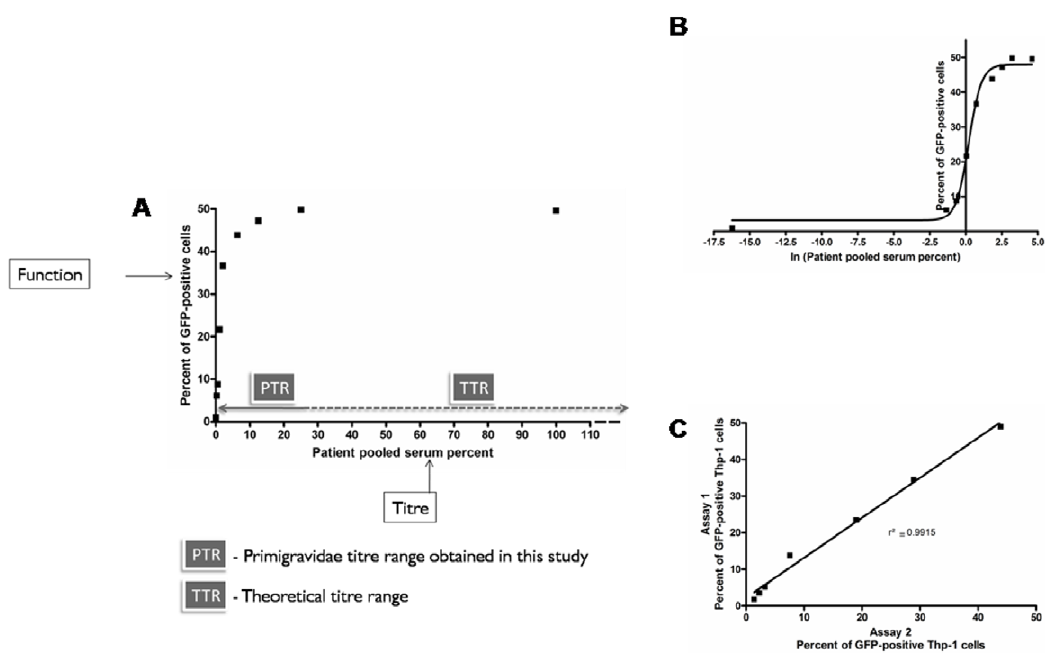
Figure 1. Phagocytosis profile of a typical uThp-1 phagocytosis assay standard curve and inter-assay reproducibility. A) Typical standard curve plot of percentage of patient pooled serum against percent of GFP-positive uThp-1 cells with indications of absolute phagocytosis values used for phagocytic antibodies’ function, titre and both the titre range obtained in this study (PTR) and a theoretical titre range (TTR) (extrapolated from the patient pooled serum titre). B) Typical transformation of standard curve results. X-axis is the natural logarithm (ln) of the patient pooled serum. Goodness of fit: r 2 =0.99. For all standard curves r 2 was always higher than 0.97. C) Correlation of results obtained on different experimental days. CS2 –GFP RBC opsonised with increasing dilutions of pooled patient serum were incubated with uThp-1 cells for 40 min and phagocytosis was measured by flow cytometry. The absolute phagocytosis values obtained on both experimental days are plotted. A dilution of 1/10 of original serum was always considered as the 100%. No-serum control would be assigned an arbitrary value of 9 6 10 2 8 %. uThp-1 cells alone were considered absolute zero. Analysis performed on GraphPad Prism v4.0